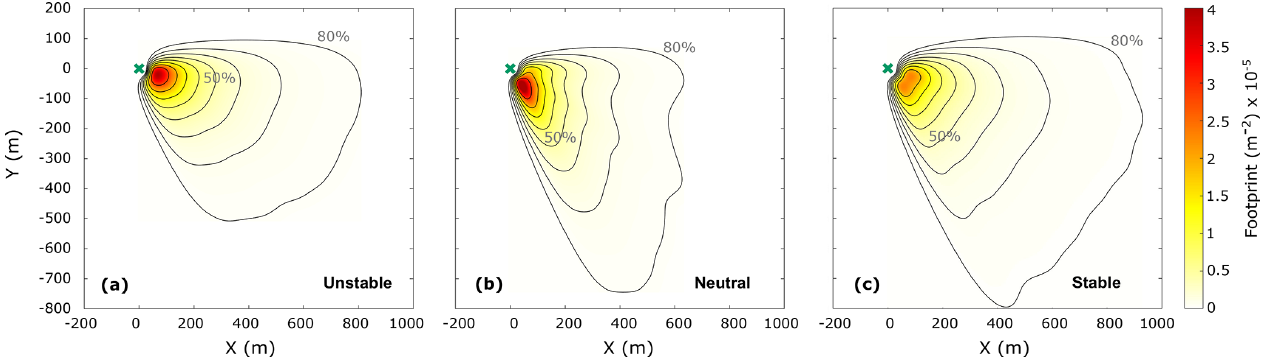
Figure 2. Average footprint distribution for (a) unstable, (b) neutral, and (c) stable atmospheric conditions. X and Y represent the horizontal domain with origin (0,0) at the tower’s location (green cross), and the contours represent the percentage of the source area from 10%–80%. The flux footprint (in colour) shows the spatial distribution of the contributions per unit area to the total F CO 2 (in m − 2 ). The footprint was calculated using the model developed by Kljun et al. (2015) using all data available for the open-sea sector between mid-2013 and